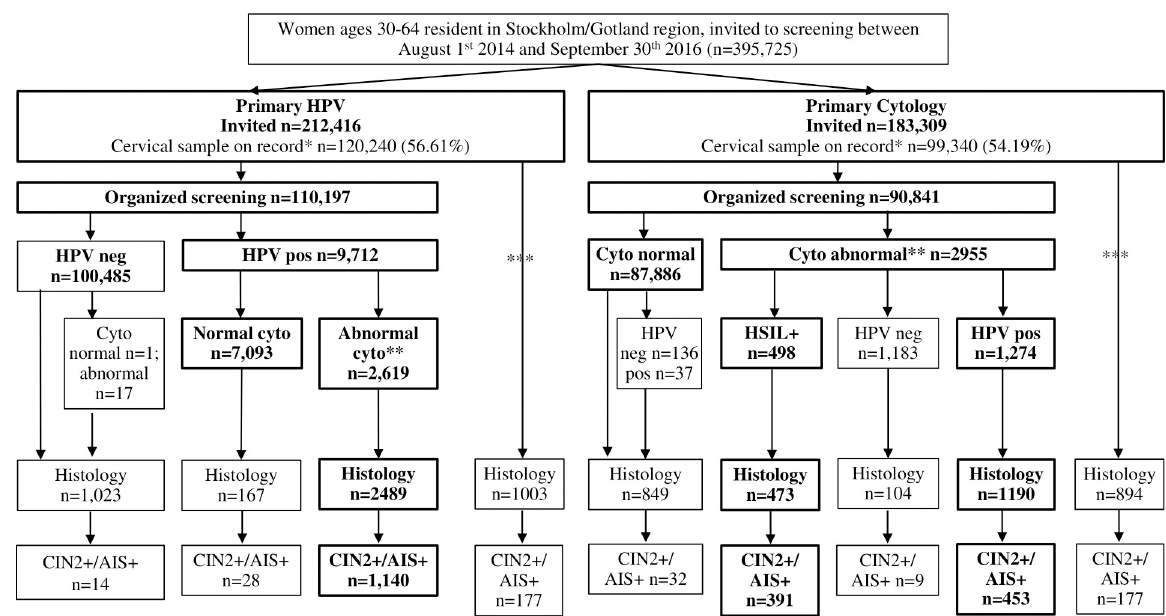
Fig 1. CONSORT flowchart of study population and outcomes. � Cervical sample on record: any cervical sample result following the first invitation to screening in the study period. �� Abnormal cytology: includes ASCUS/AGC+. ��� Includes protocol violations, inadequate samples, pathology samples without proceeding smear, non-organized screening samples, and clinically indicated samples (total: n = 10,043 in the primary HPV arm and n = 8,499 in the primary cytology arm). Note: Bolded text denotes the PP population participation and outcomes. AGC+, atypical glandular cells or worse; AIS+, adenocarcinoma in situ or worse; ASCUS, atypical squamous cells of undetermined significance; CIN2+, cervical intraepithelial neoplasia grade 2 or worse; CONSORT, Consolidated Standards of Reporting Trials; Cyto, cytology; HPV, human papillomavirus; PP, per